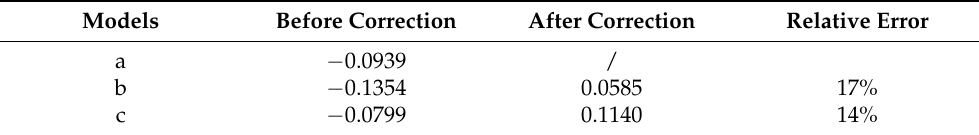
Table 4. Inversion results of radius of non-homogeneous medium